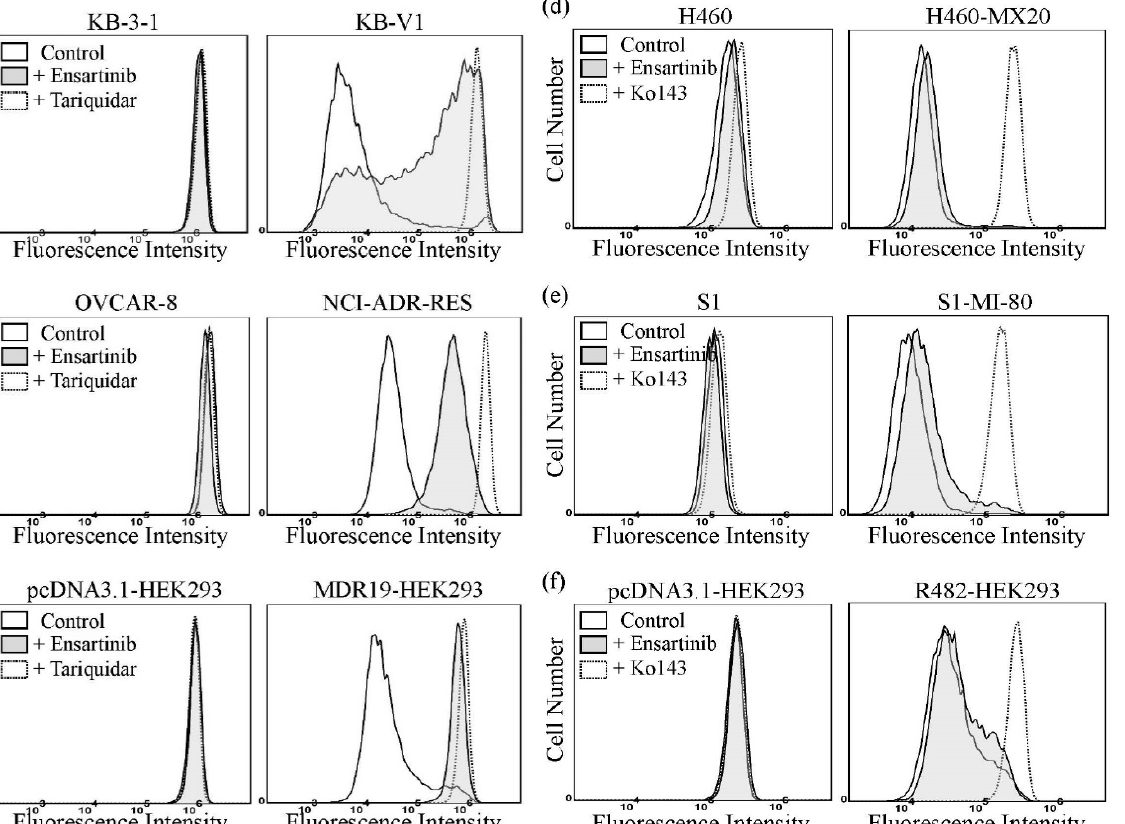
pendent experiments as described in Materials and Methods. * p < 0.05; ** p < 0.01.